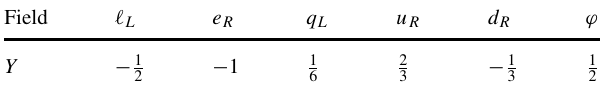
Table 2 Hypercharge assignments in the SMEFT